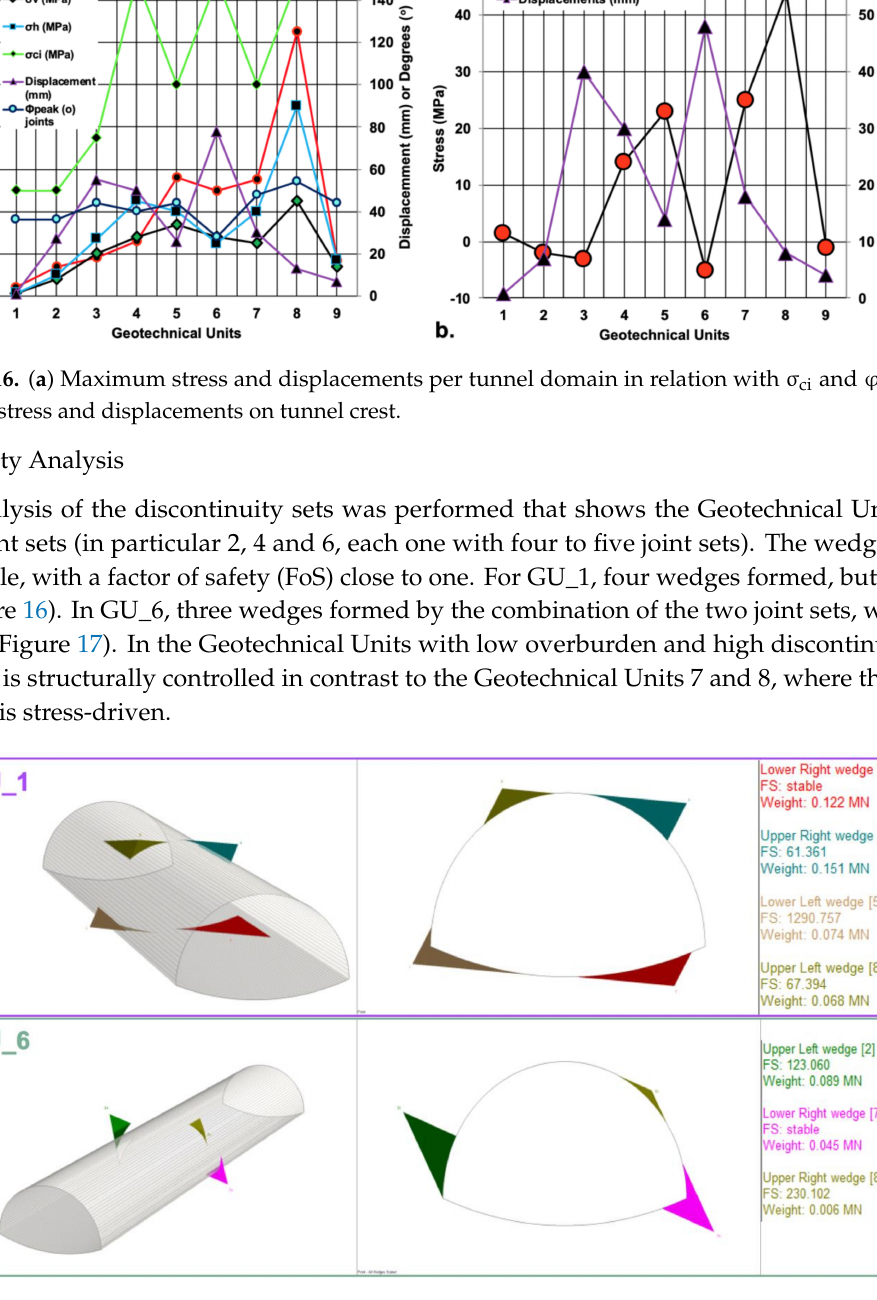
Figure 17. Stability analysis using Unwedge [53] for Geotechnical Unit 1 and 6 (GU_1 and